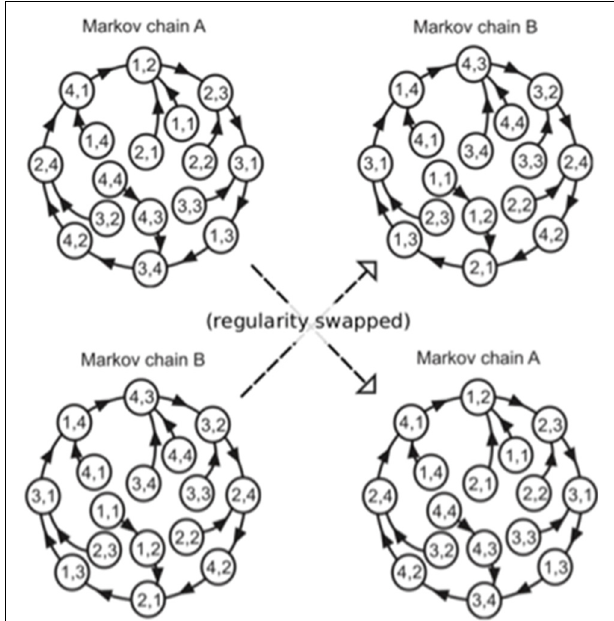
FIGURE 2 | The Markov models used in the present study (Daikoku and Yumoto, 2017). The paired digits in the circles represent two successive tones in the stimulus sequence. The distinct two Markov chains (A,B) were used in each of the low and high voices, and the use of Markov chains was counterbalanced across participants. The solid arrows represent transitions from each state with a high probability (80%). The remaining possible transitions from each state to the other three states occurred with a low probability (6.67% each). In the last third of the sequence, the Markov models controlling sequential regularity of the low and high voices were